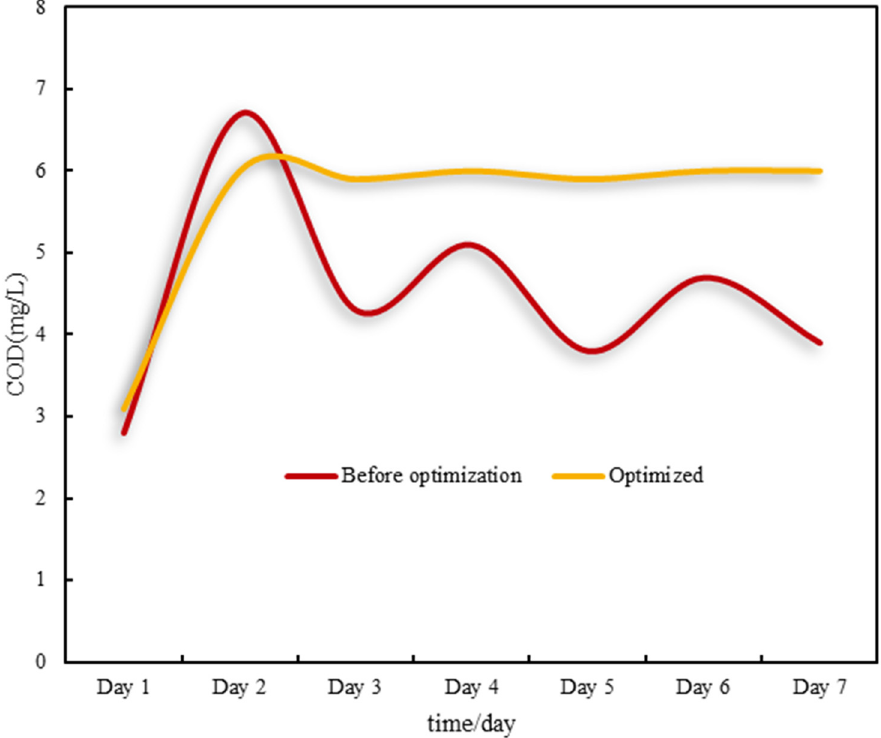
Figure 4. Adjustment and control results of the oxygen demand concentration in the sewage treatment process using the MOPSO